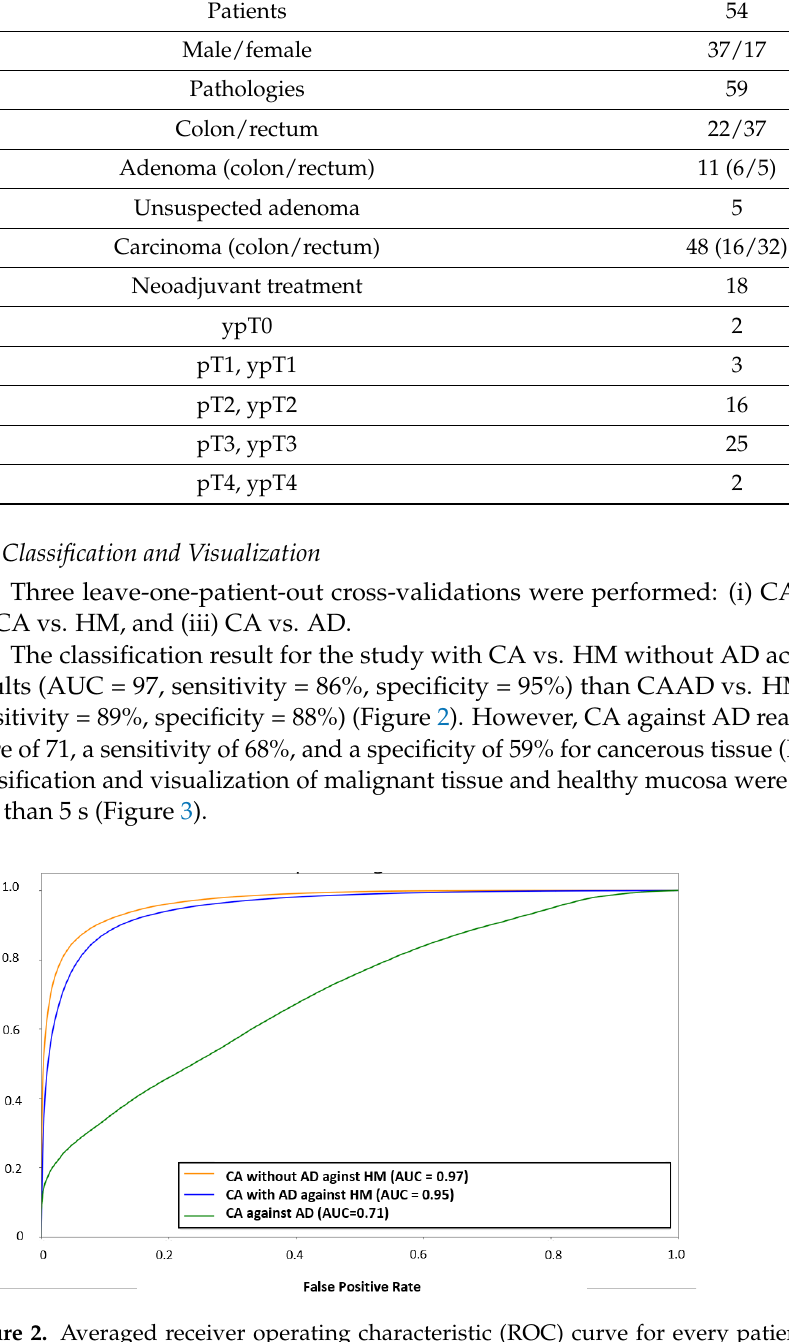
Figure 2. Averaged receiver operating characteristic (ROC) curve for every patient’s individual evaluation for classification: Cancer (CA) with adenomatous margin around the central tumor (AD) against healthy mucosa (HM), CA without AD against HM, and CA against AD (AUC — area under the curve).